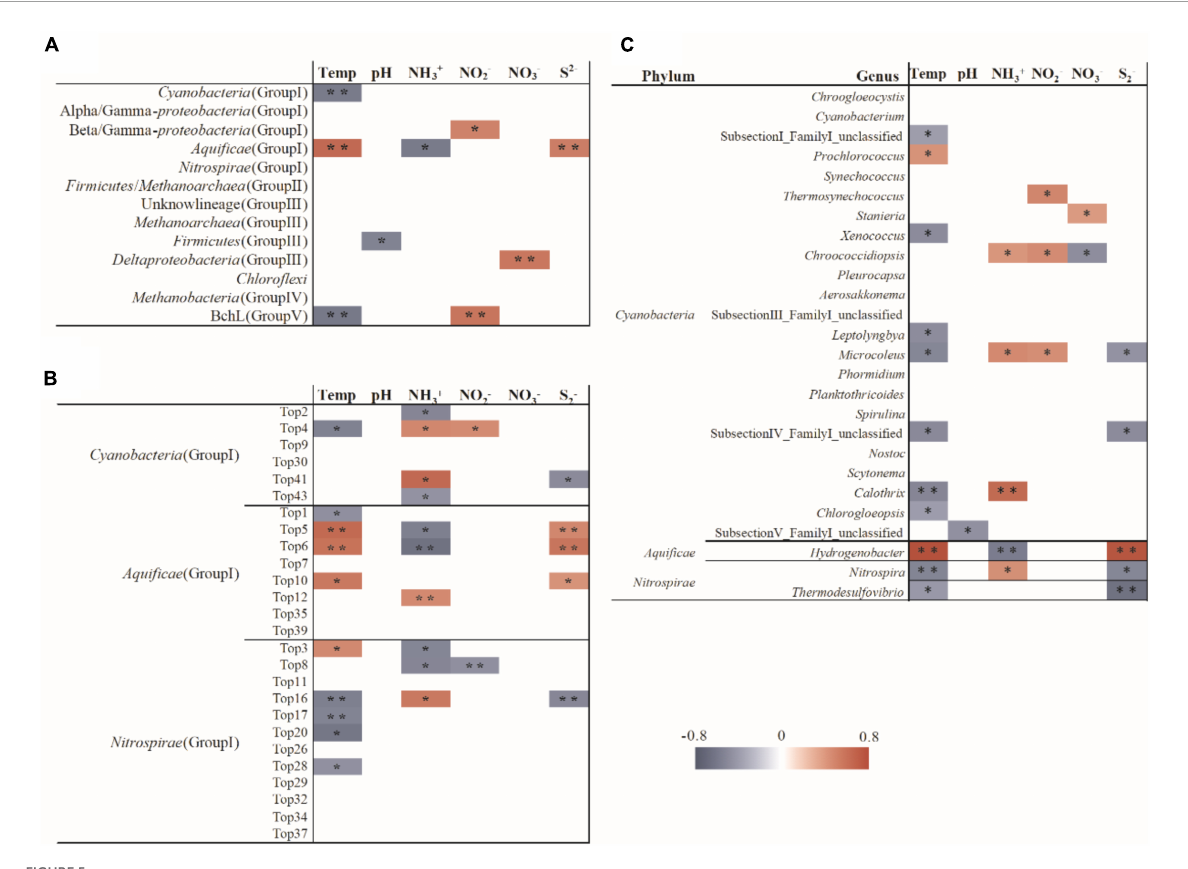
FIGURE5 Spearman correlation between the measured environmental variables and the relative abundance of the nifH gene lineages (A) , nifH OTUs (B) and the 16S rRNA gene of potential diazotrophic genera (C) . ∗∗ p < 0.01 and ∗ p < 0.05.